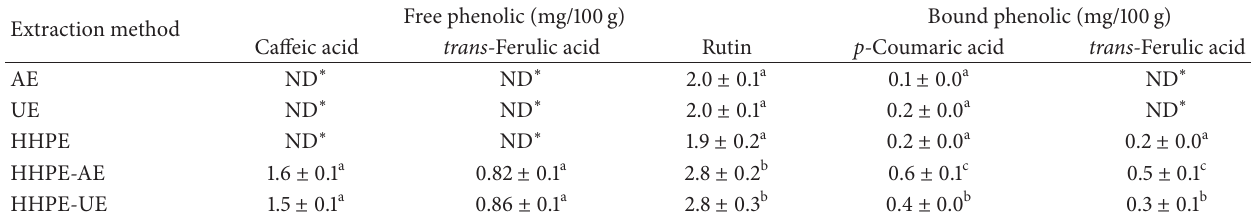
Table 3: Comparison between free phenolic and bound phenolic compounds from Chilean papaya. Extraction method